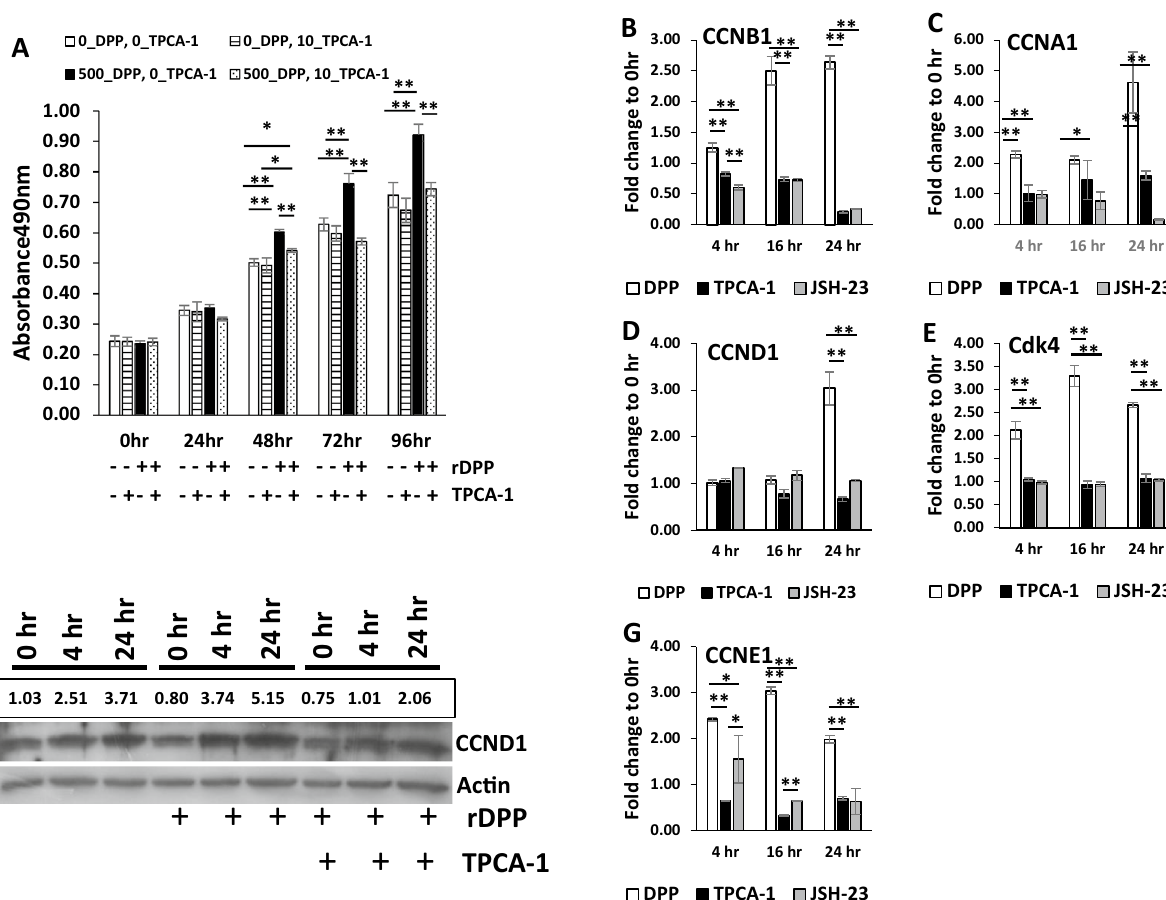
Figure 3. DPP promotes cellular proliferation by NF-κB activation. ( A ) DPSCs were cultured were treated with (closed bar) or without TPCA-1 (open bar) for 60 min and stimulated with 500 ng DPP and cultured under growth conditions for 0–96 h. ( B ) DPSCs were treated with or without TPCA-1 for 60 min and then stimulated with DPP for 0, 4 and 24 h. Western blot analysis was performed to assess the expression levels of cyclin D1. ( C ) DPSCs were treated with or without NF-κB pathway inhibitors TPCA-1 or JSH-23 for 60 min and then stimulated with DPP at the indicated time points. Expression of cyclin B1 levels were assessed by RT-PCR. Fold change was obtained relative to 0 h. ( D ) DPSCs were treated with or without NF-κB pathway inhibitors TPCA-1 or JSH-23 for 60 min and then stimulated with DPP at the indicated time points. Expression of cyclin D1 levels were assessed by RT-PCR. Fold change was obtained relative to 0 h. ( E ) DPSCs were treated with or without NF-κB pathway inhibitors TPCA-1 or JSH-23 for 60 min and then stimulated with DPP at the indicated time points. Expression of cyclin E1 levels were assessed by RT-PCR. Fold change was obtained relative to 0 h. ( F ) DPSCs were treated with or without NF-κB pathway inhibitors TPCA-1 or JSH-23 for 60 min and then stimulated with DPP at the indicated time points. Expression of cyclin A1 levels were assessed by RT-PCR. Fold change was obtained relative to 0 h. ( G ) DPSCs were treated with or without NF-κB pathway inhibitors TPCA-1 or JSH-23 for 60 min and then stimulated with DPP at the indicated time points. Expression of Cdk4 levels were assessed by RT-PCR. Fold change was obtained relative to 0 were measured as percentages to total input DNA subjected to immunoprecipitation followed by qPCR. Upon DPP treatment, binding of p65 components of NF-κB to the putative binding sites in the promoter elements of several matrix genes such as OSX, OCN, MMP1, ALP, BMP4, TWIST1, and PTX3 showed distinct enrichment over the input chromatin compared to that of an IgG negative control antibody. No chromatin enrichment was observed with primers from adjacent random regions (Fig. 8). For the OSX promoter, the NF-κB binding chro- matin enrichment upon DPP treatment peaked at 1 h, and then reduced but was still higher than without DPP stimulation (Fig. 7A). OCN DNA element A showed chromatin enrichment at 1 h and stayed high at 2 h, while element B peaked at 1 h (Fig. 8B). The MMP1 element C showed strong response to the DPP treatment at 1 h (Fig. 8C). With alkaline phosphatase, A and B elements p65 binding with DPP treatment showed slightly lower binding; while C element had consistent low binding upon DPP treatment; only enrichment of D element peaked at 1 h rDPP treatment (Fig. 8D). In the case of BMP4, A binding site was high at 0 h, and DPP stimulation at 1 h increased chromatin enrichment (Fig. 8E). DNA binding activity of TWIST1 A + B and C were increased upon DPP treatment, particularly at 1 h (Fig. 8F). Chromatin enrichment was observed with the three NF-κB DNA elements (A, B and C) in PTX3 (Fig. 8G).